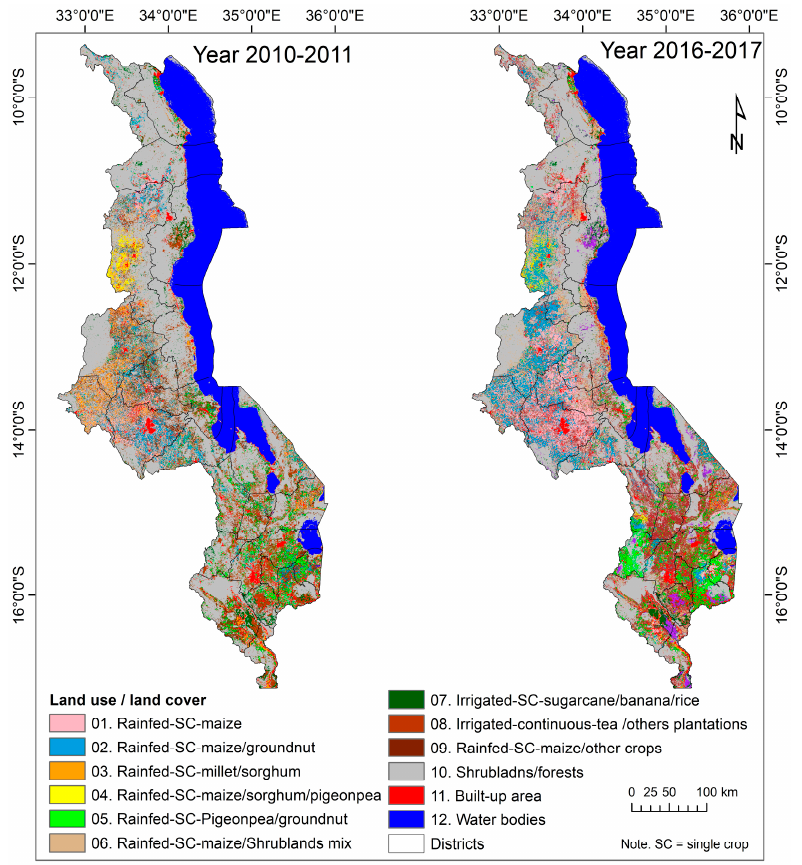
Figure 4. Spatial distribution of land use / land cover along with major cropping pattern for both